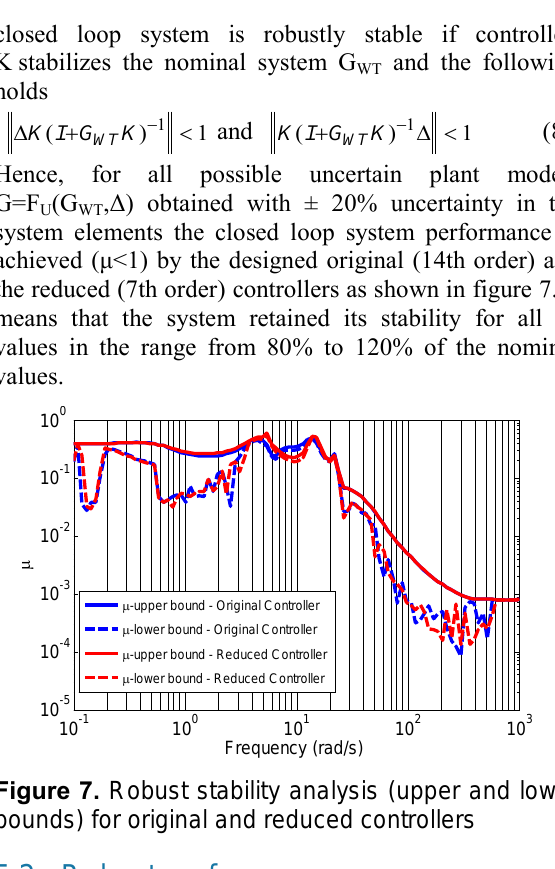
Figure 7. Robust stability analysis (upper and lower bounds) for original and reduced controllers